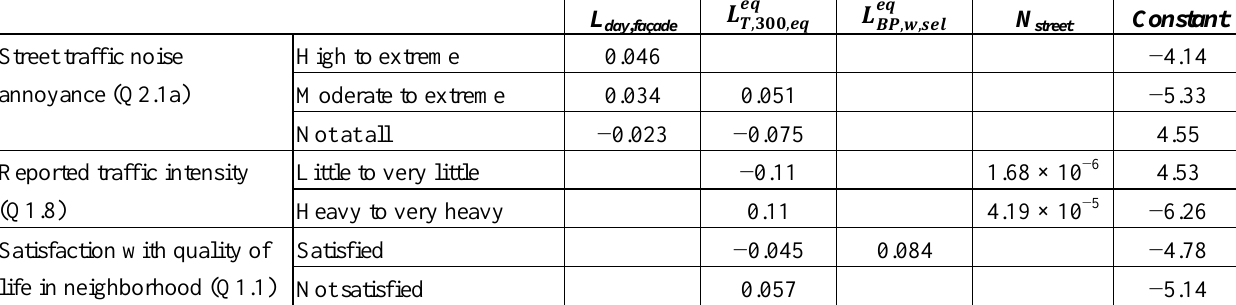
Table 10. β coefficients in the multiple logistic regression models that were